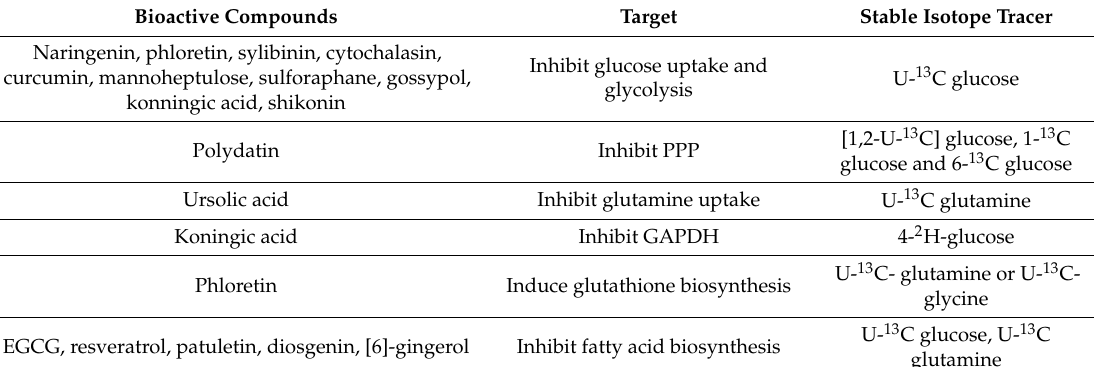
Table 2. Use of stable isotope tracer for analyzing the metabolic activity of bioactive